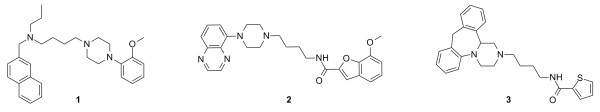
Three dopamine D3 receptor ligands. Reference compound 1 and test molecules 2 and 3.